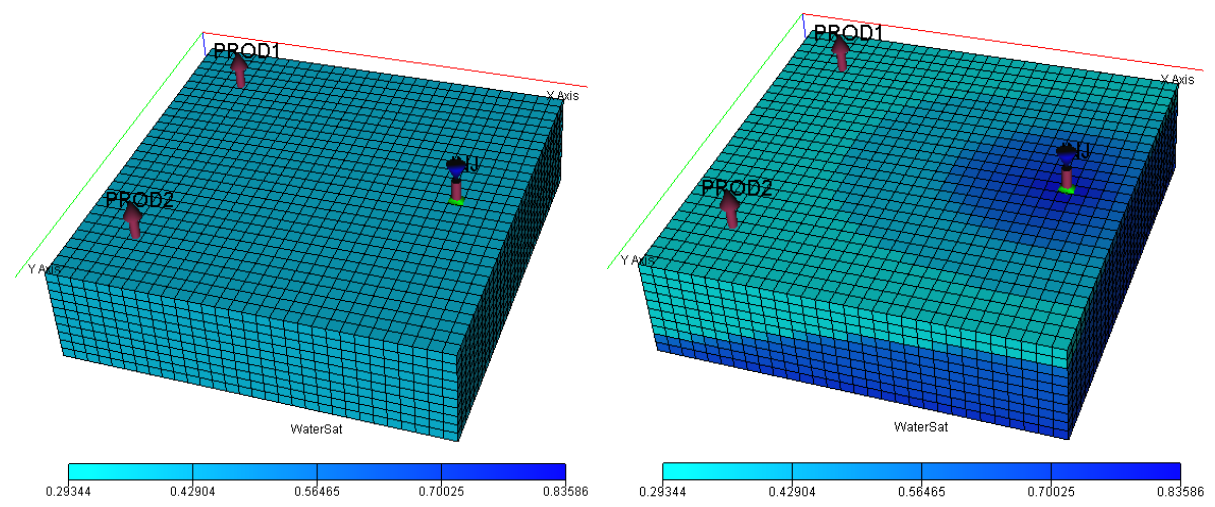
Figure 18. Before (a) and after ( b ) 3D simulated water saturation.